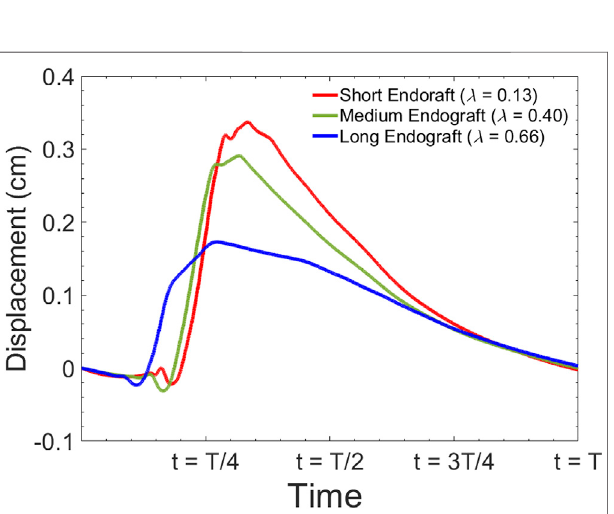
FIGURE8| Spatialdistributionof fl uidandsolidbehaviorintheFSItype-Bdissectionmodelatvarioustimesduringthecardiac cycle.Thezig-zagboundaryshows the graft (rigid) schematically and the dashed wall represent the axis of the symmetry. The fl ow direction is from left to the right.